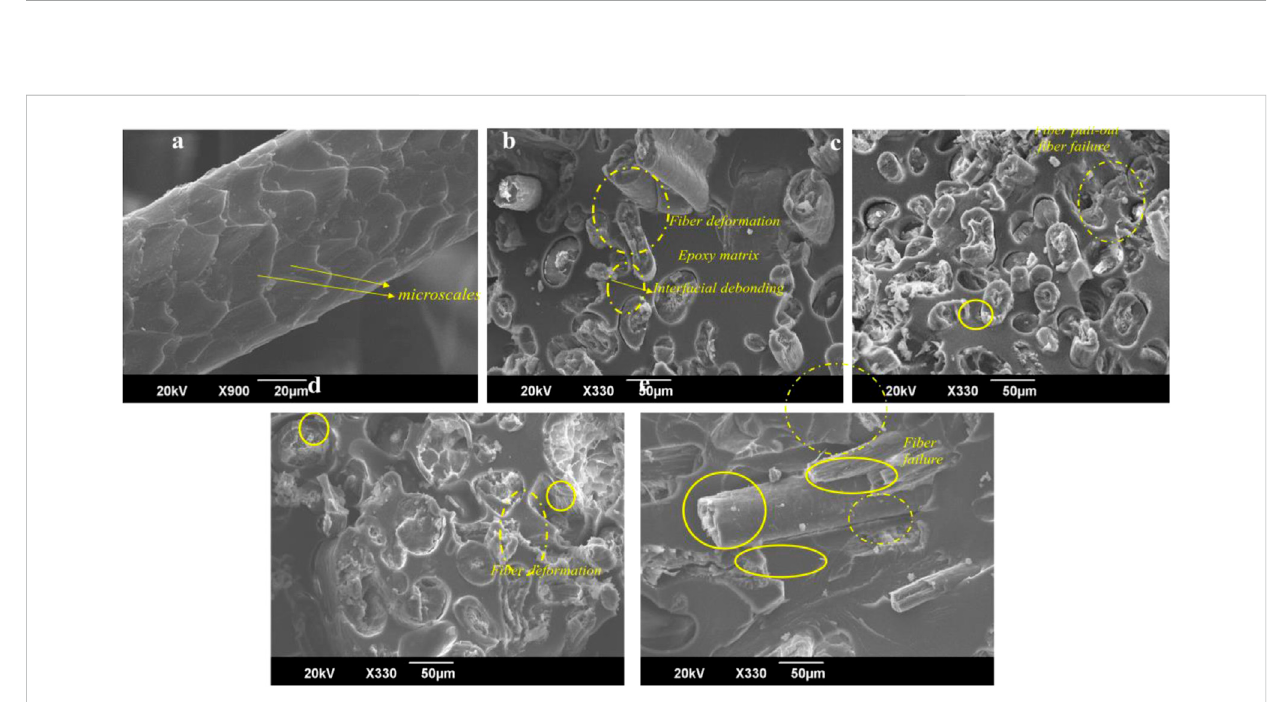
FIGURE 3 SEM images of (A) Coarse wool fi ber, tensile fractured surfaces of (B) EWS-0, (C) EWS-0.5, (D) EWS-2.5, and (E)